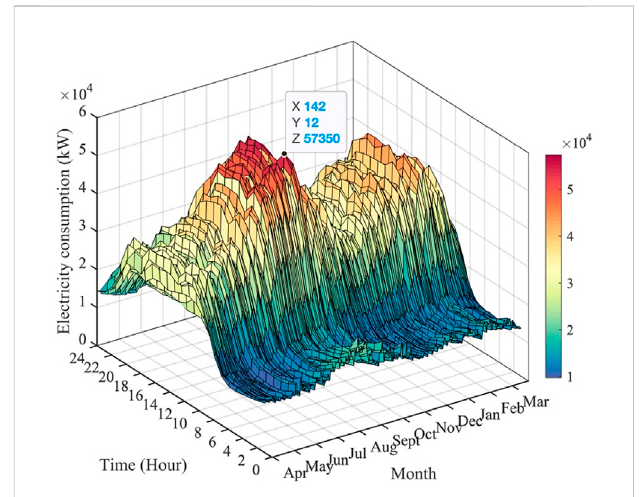
FIGURE 6 Energy consumption of the H Community in 1